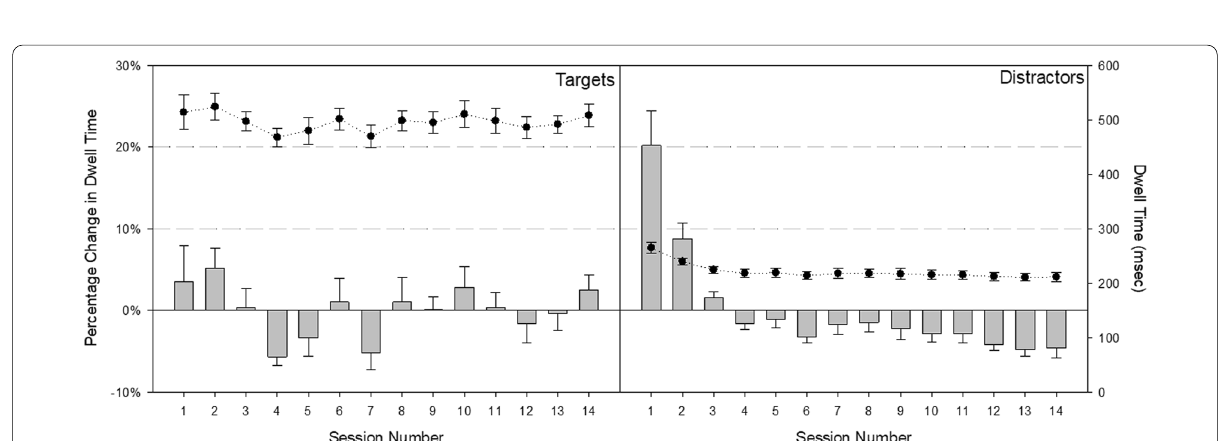
Fig. 7 Average dwell time (circles) and percent change average dwell time (bars) across sessions for targets (left graph) and distractors (right graph). Error bars reflect 1 standard ±